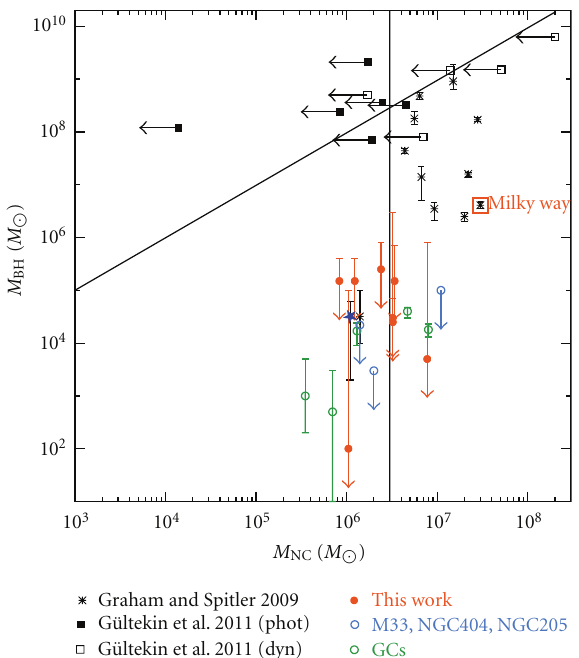
Figure 5: The mass of the BH mass versus the NC mass. We plot the objects as listed in the text. The two full lines indicate an NC mass of 3 × 10 6 M (cid:2) and a M BH /M NC mass ratio of 100. These lines separate NC-dominated galaxy nuclei (lower left of both lines) from BH- dominated galaxy nuclei (upper left of both lines) and a transition region (to the right of both